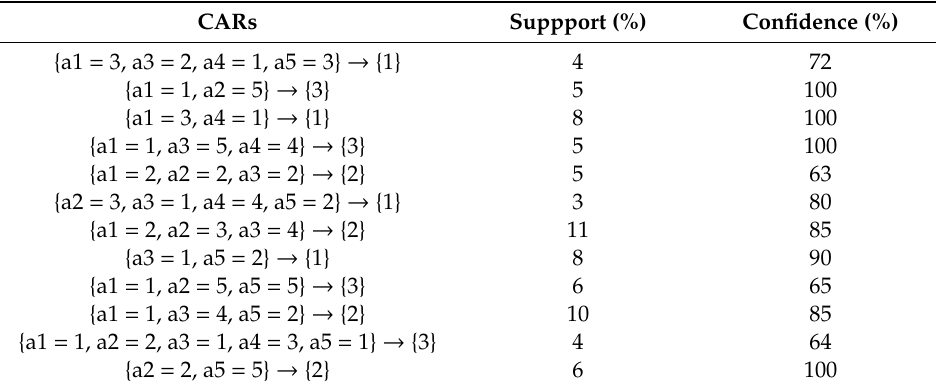
Table 2. Generated CARs from the training dataset